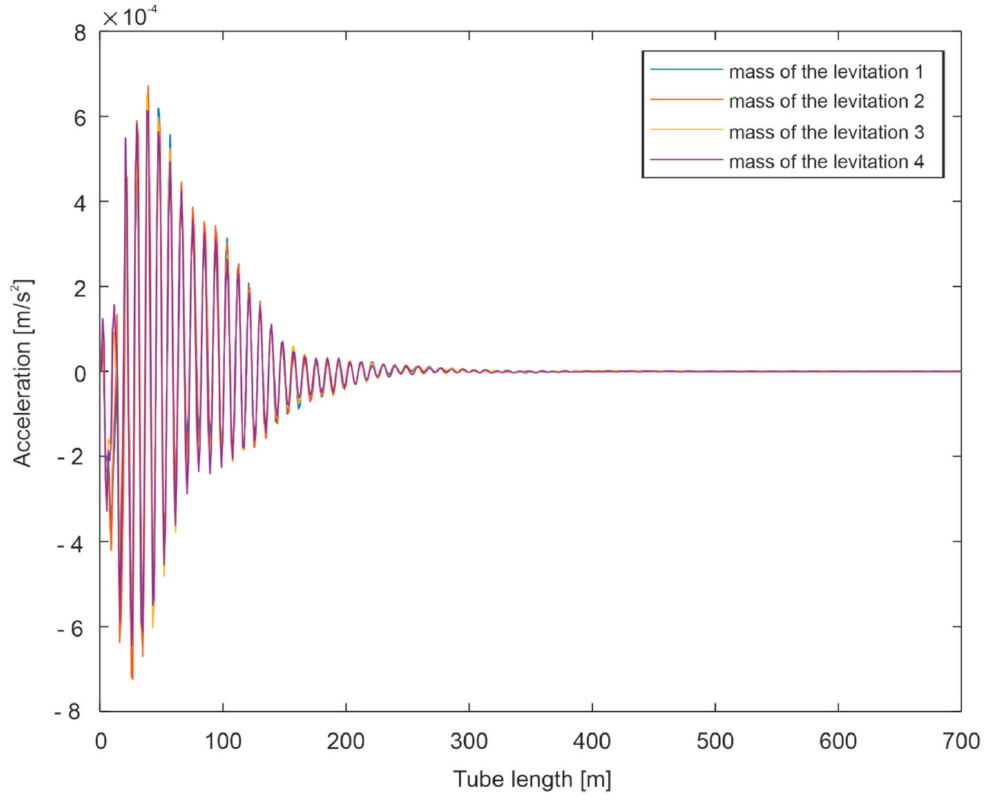
Figure 25. Acceleration on the levitation system in the direction y for 2000 km /